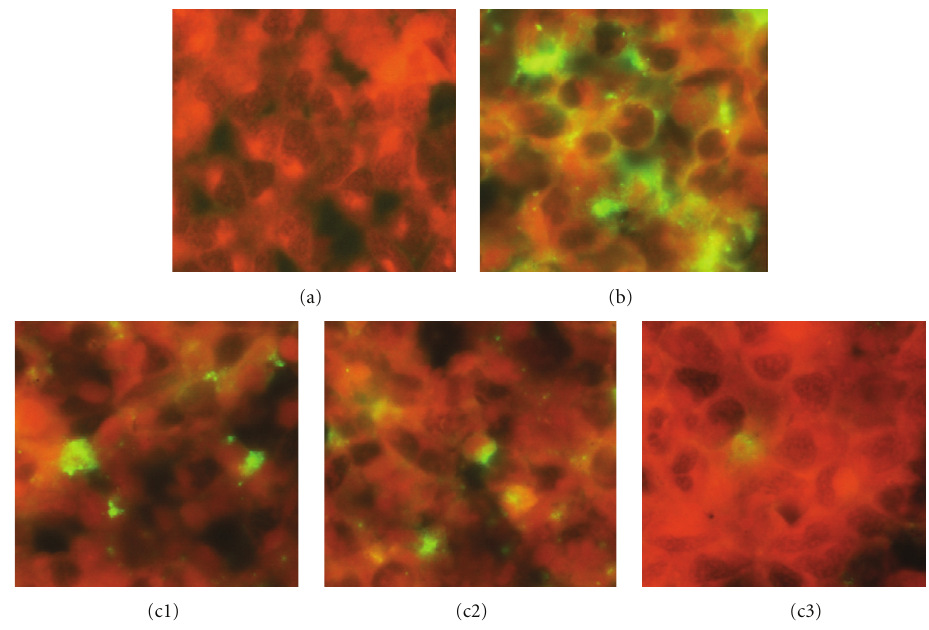
Figure 1: HL cells were plated, grown, and infected with C. pneumoniae at MOI 1 . Additions of the Roquefort cheese protein extract with final concentrations of 0.12, 0.25, and 0.50 mg/mL were performed simultaneously with the bacterial pathogen inoculation. The cell monolayers were harvested after 72h incubation at 35 ∘ C in 5% CO 2 and immunofluorescent staining conducted as described in Section 2. Inhibition of C . pneumonia growth by roquefort protein extract ((a) uninfected cells; (b) infected cells; (c1), (c2), and (c3) infected cells grown in the presence of 0.12, 0.25, and 0.50 mg/mL Roquefort protein extract, resp.).